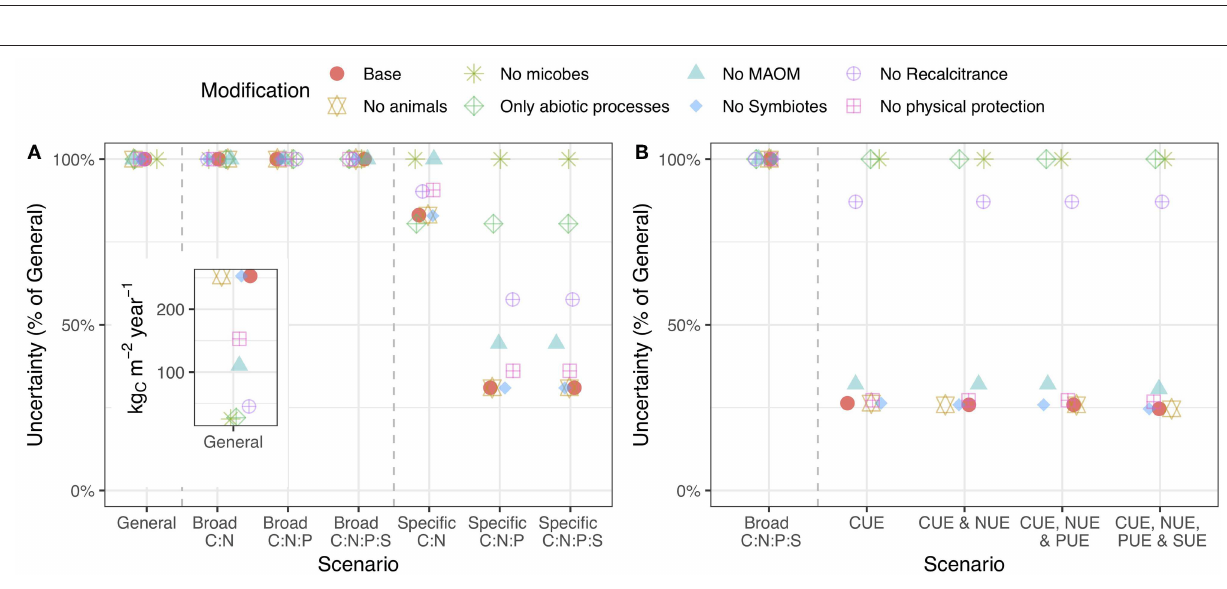
efficiency information had no effect on uncertainty even though animals were still included ( Figure 4B ). Removing